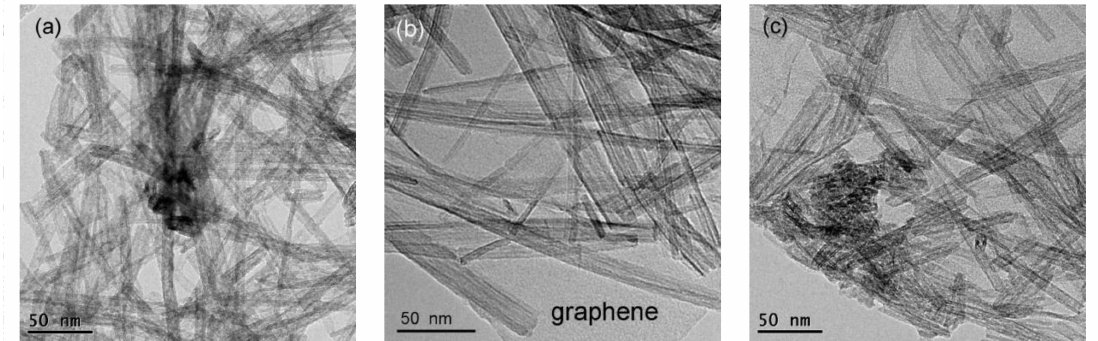
Figure 4. Typical TEM images of ( a ) pure HTT, ( b ) HTT/graphene-1.0%, and ( c ) HTT/graphene-1.0%- mixed nanocomposites.